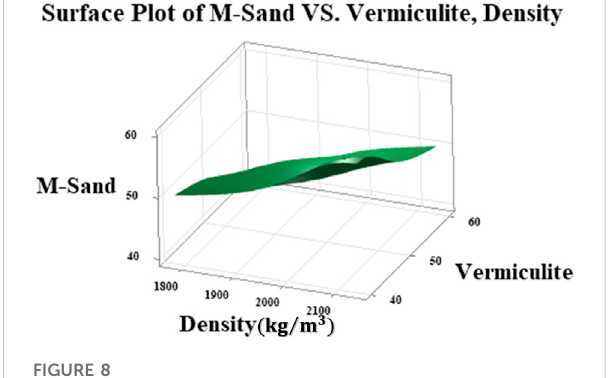
FIGURE 8 Surface plot for density.